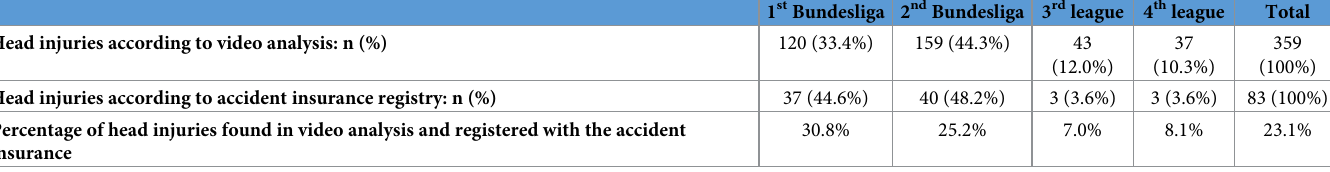
Table 2. Head injuries determined by video analysis and confirmed by the accident insurance